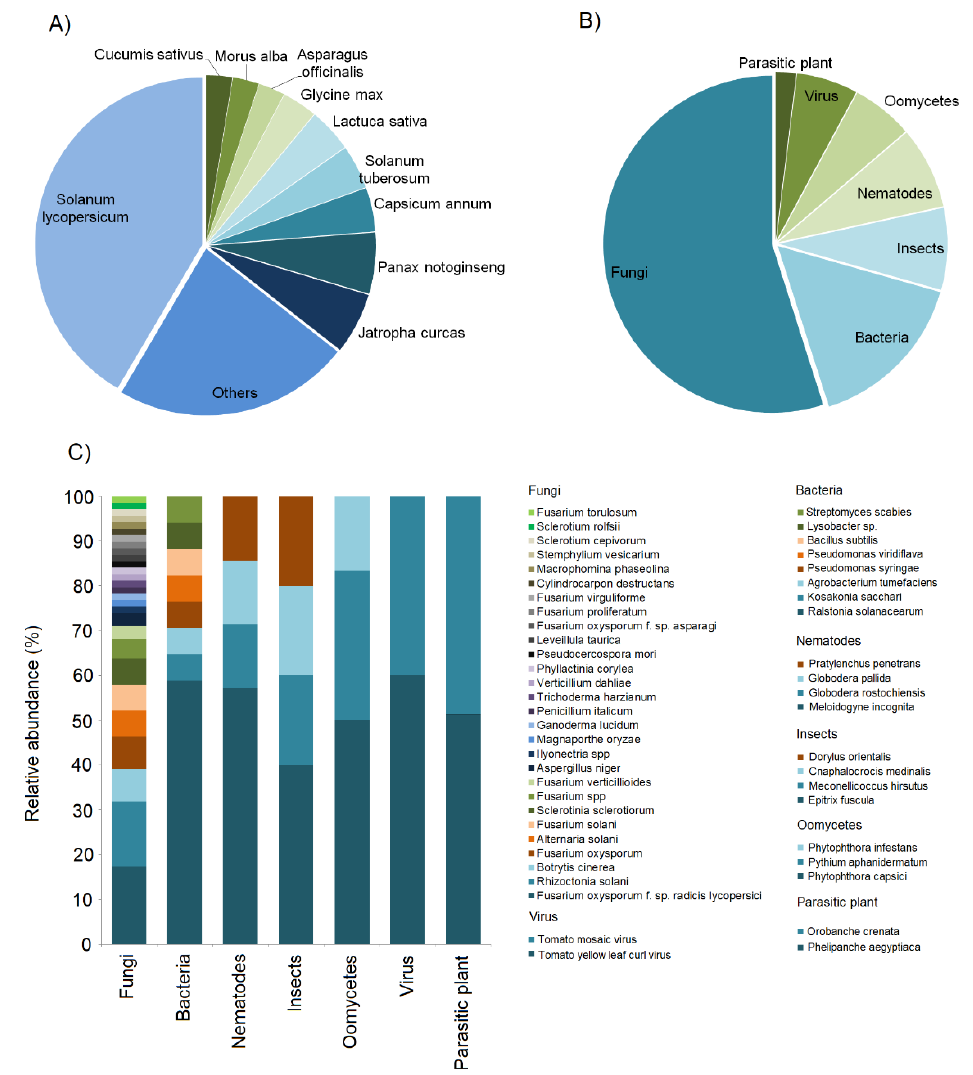
Figure 1. Pie charts representing the proportion of plants ( A ) and pathogen and pest types ( B ) in the systems investigated regarding biochar for pest control and disease suppression in the last seven years. ( C ) Stacked bar charts represent the relative abundances of studied pathogens and pests at the species level.